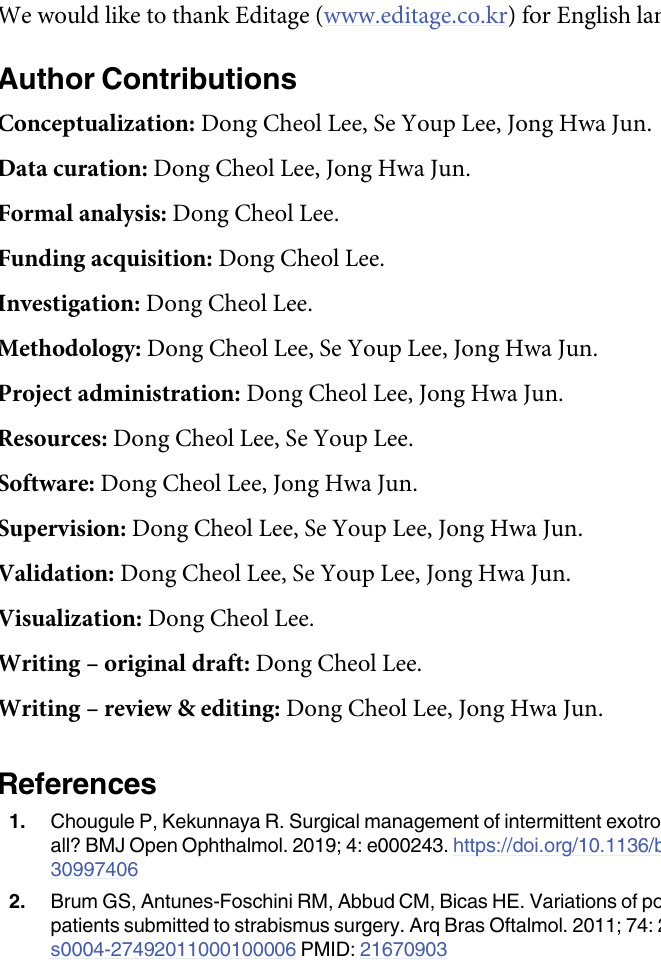
S1 Table. Classification of the extent of surgery by exodeviation prism diopter. LR: lateral rectus; MR: medial rectus; PD: prism diopter. S2 Table. Changes in the IOP, refraction, corneal power, LOAs, and HOAs compared to the preoperative baseline. IOP: intraocular pressure; LOA: lower-order aberrations; HOA: high-order